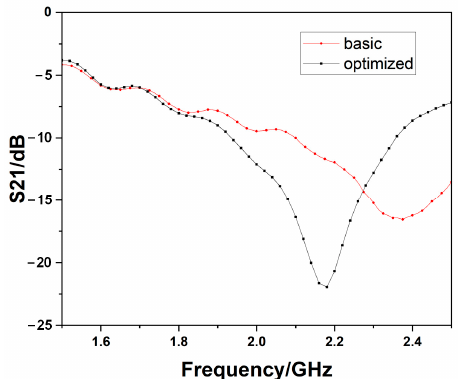
Figure 8. The measurement results of the bare devices.